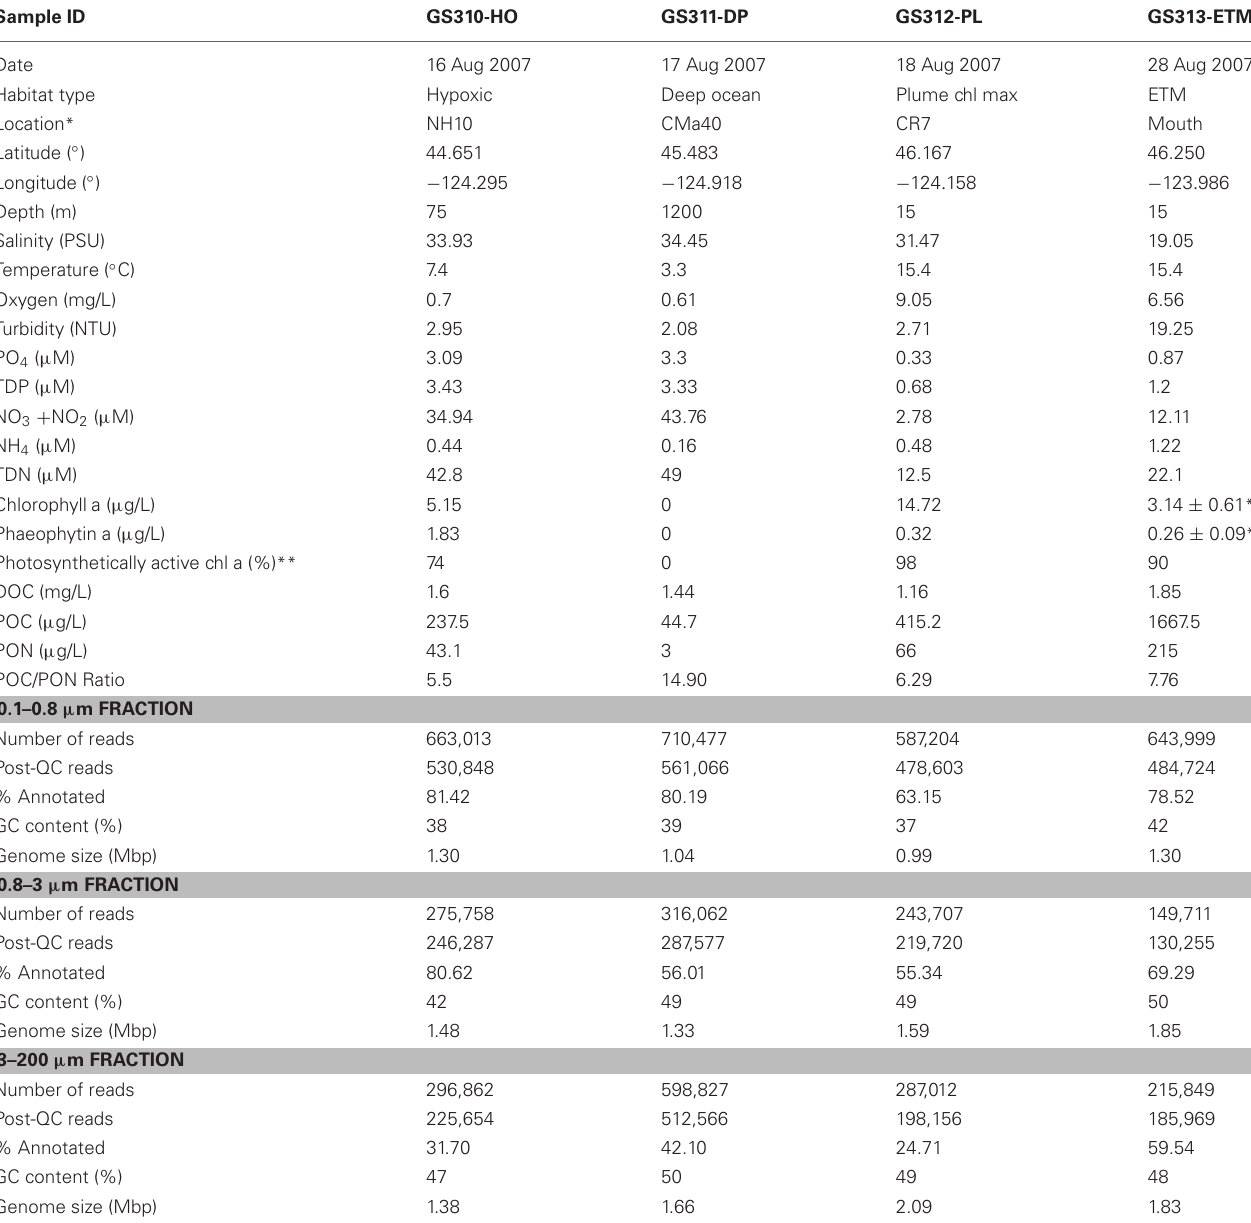
Table 1 | Environmental metadata and sequencing